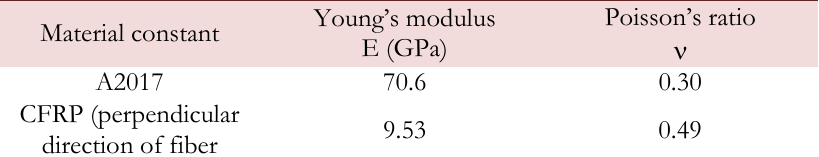
Table 1: Material constants.